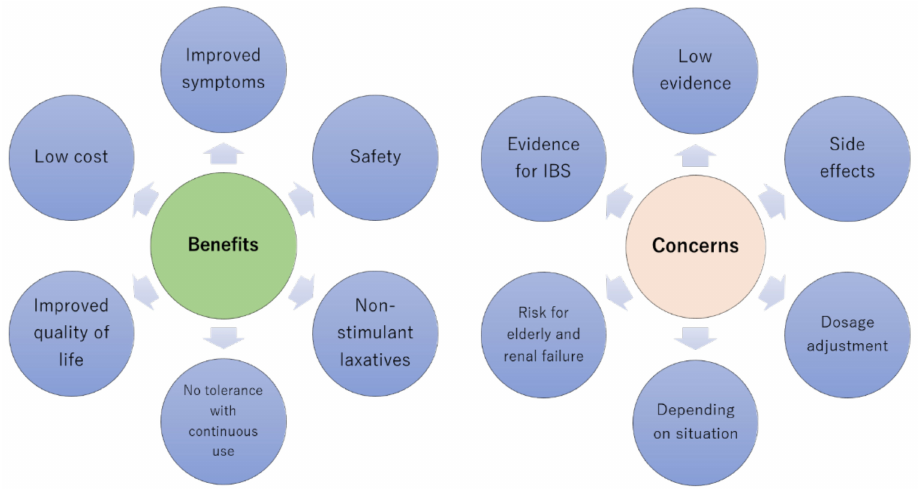
Figure 3. The advantages and disadvantages of magnesium oxide therapy. IBS, irritable bowel